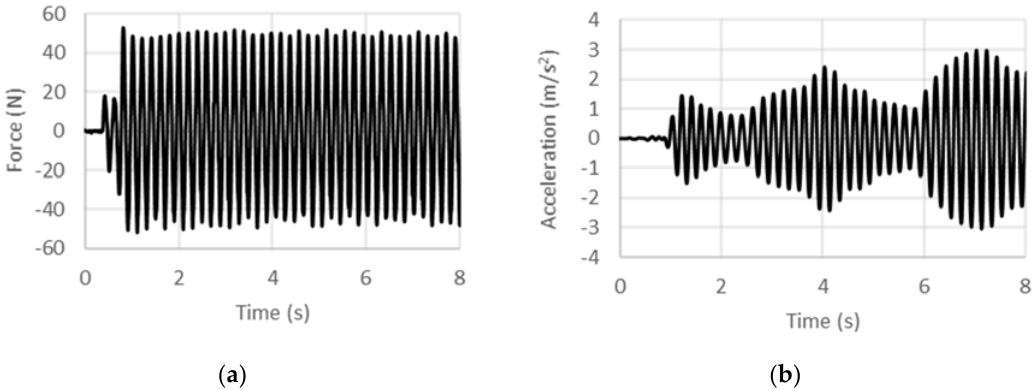
Figure 11. Experimental ( a ) force and ( b ) acceleration histories at 5 Hz under displacement control.